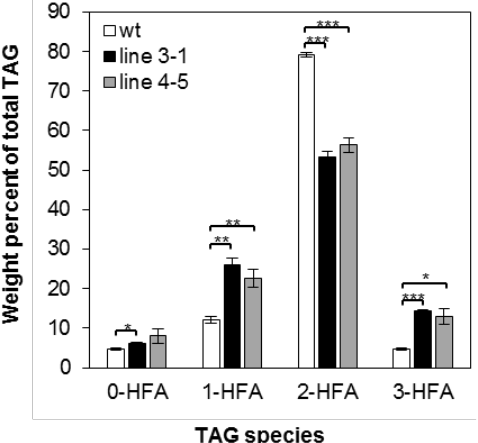
Figure 2. Molecular species composition of TAG. TAG molecular species in seeds of wild type (wt) (open bars) and transgenic line 3-1 (black bars), line 4-5 (grey bars) are measured as a weight percent of total TAG. 0-, 1-, 2-, and 3-HFA represent TAG molecular species with zero, one, two, or three HFAs, respectively (no stereochemistry implied). Triplicates of 50-seed sample were measured for wild type and transgenic lines. The HFAs represent the sum of 18:1OH and 20:1OH. FA numerical symbols are described as in Table 2. The data represent averages of three replicates ± SE. Two-tailed Student’s t test. * p < 0.05; ** p < 0.01; *** p < 0.001.